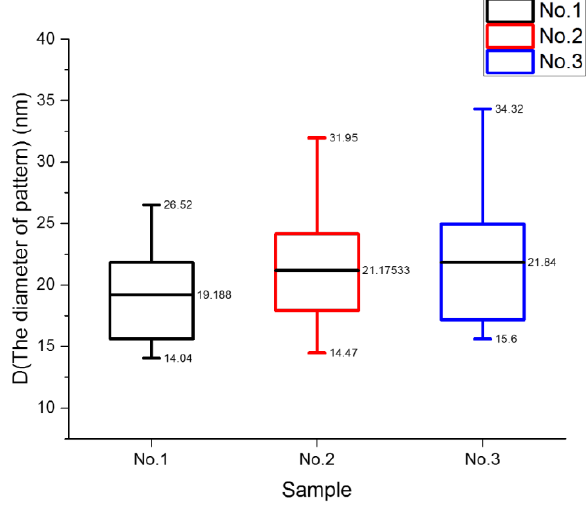
Figure 6. Box diagram of cylinder diameter for different samples .